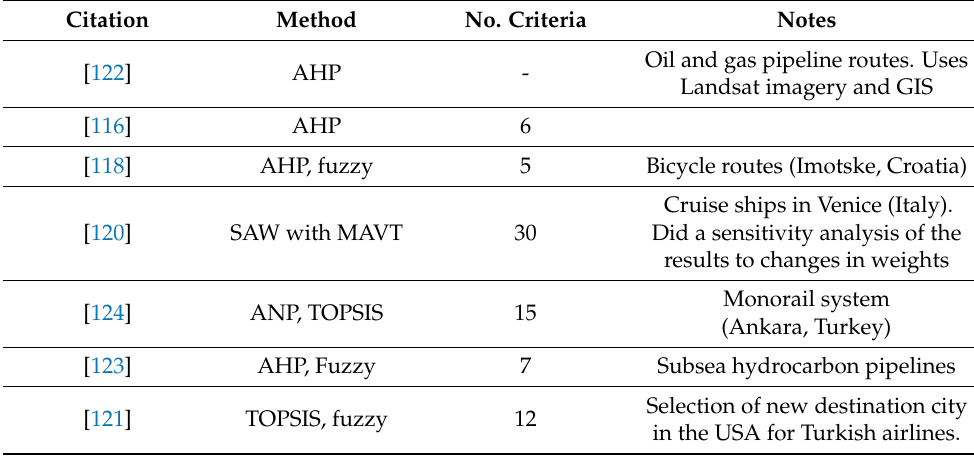
Table 10. Examples of applications of MCDA to route selection